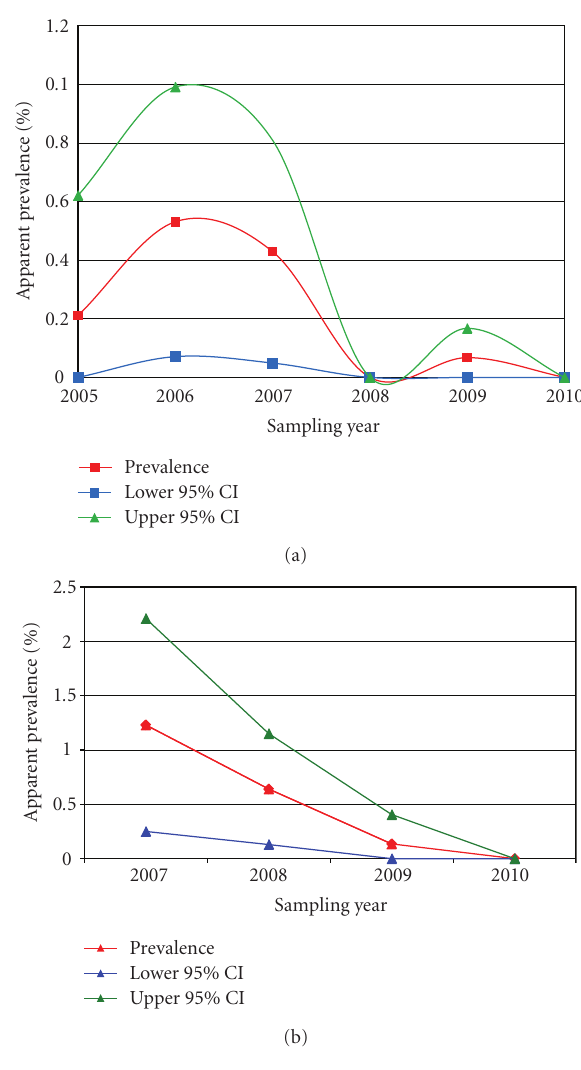
Figure 2: (a) Prevalence of bovine tuberculosis (bTB) in hunter- harvested deer from 2005–2010 in the Bovine TB Surveillance Zone. (b) Prevalence of bTB from sharpshooter-removed deer from 2007– 2010 in the Bovine TB Core Area, northwest